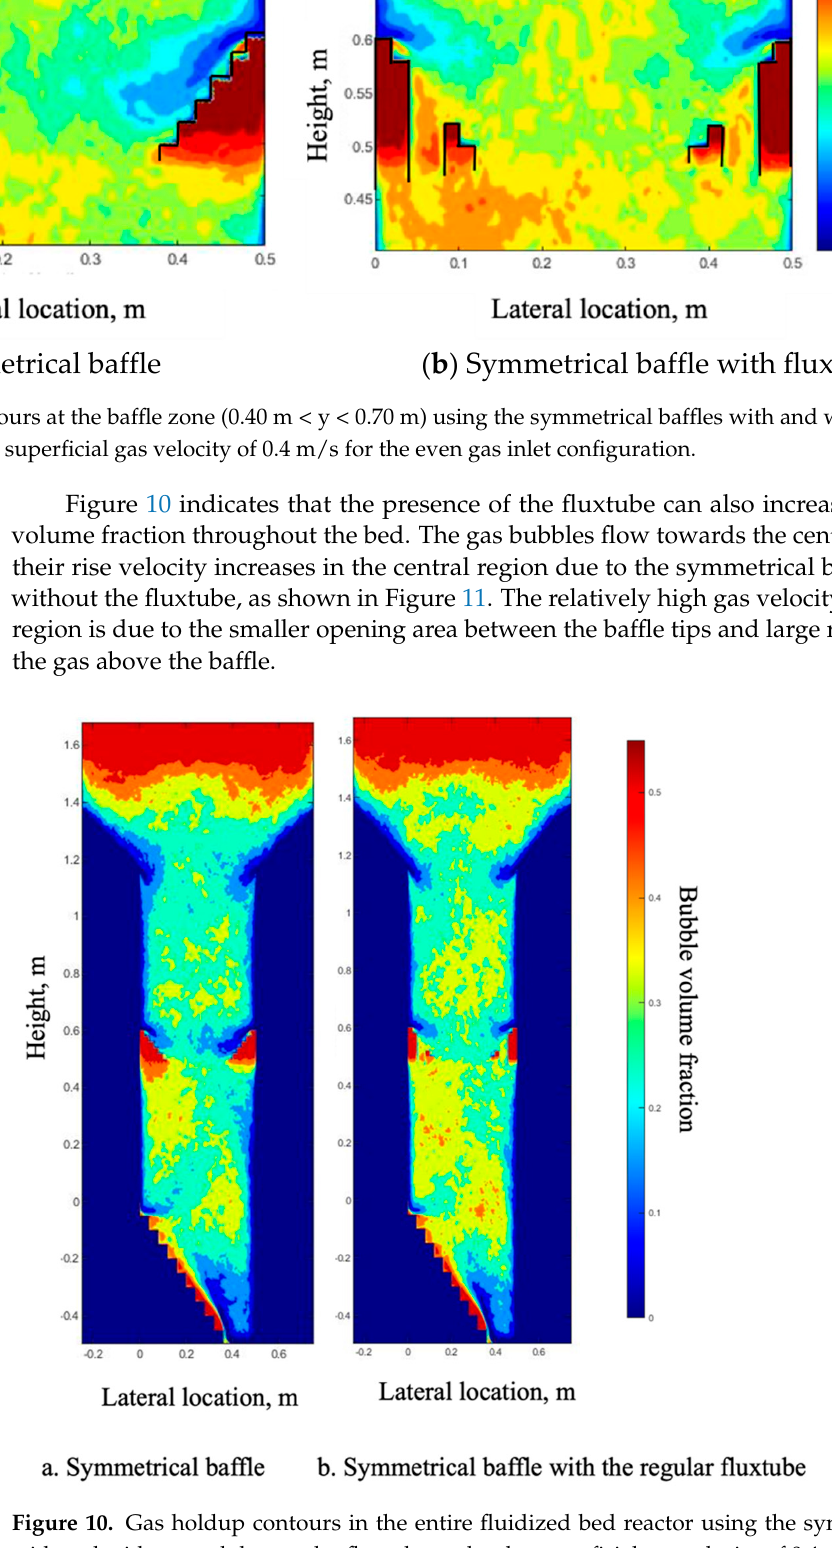
Figure 10. Gas holdup contours in the entire fluidized bed reactor using the symmetrical baffle with and without and the regular fluxtube under the superficial gas velocity of 0.4 m/s for even gas inlet configuration .